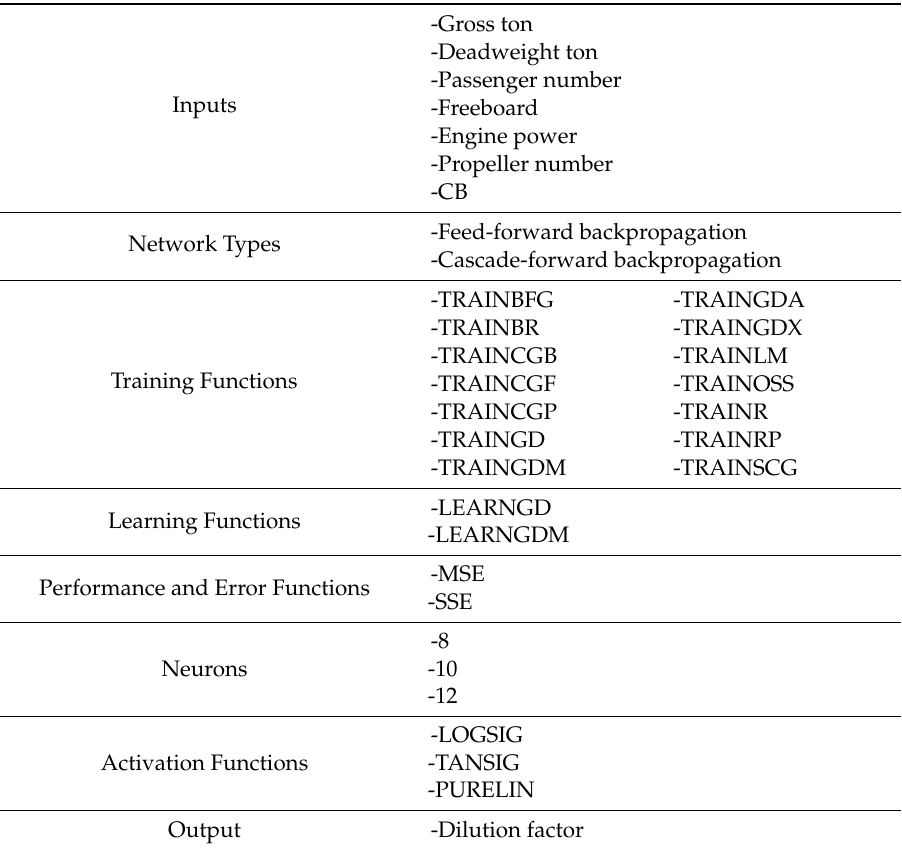
Table 1. Inputs, outputs and functions used in ANN